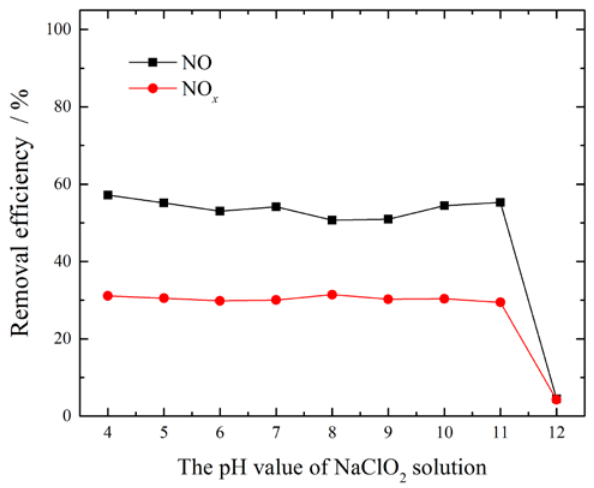
Figure 10. Effect of the pH value on the NO and NO x removal efficiencies.